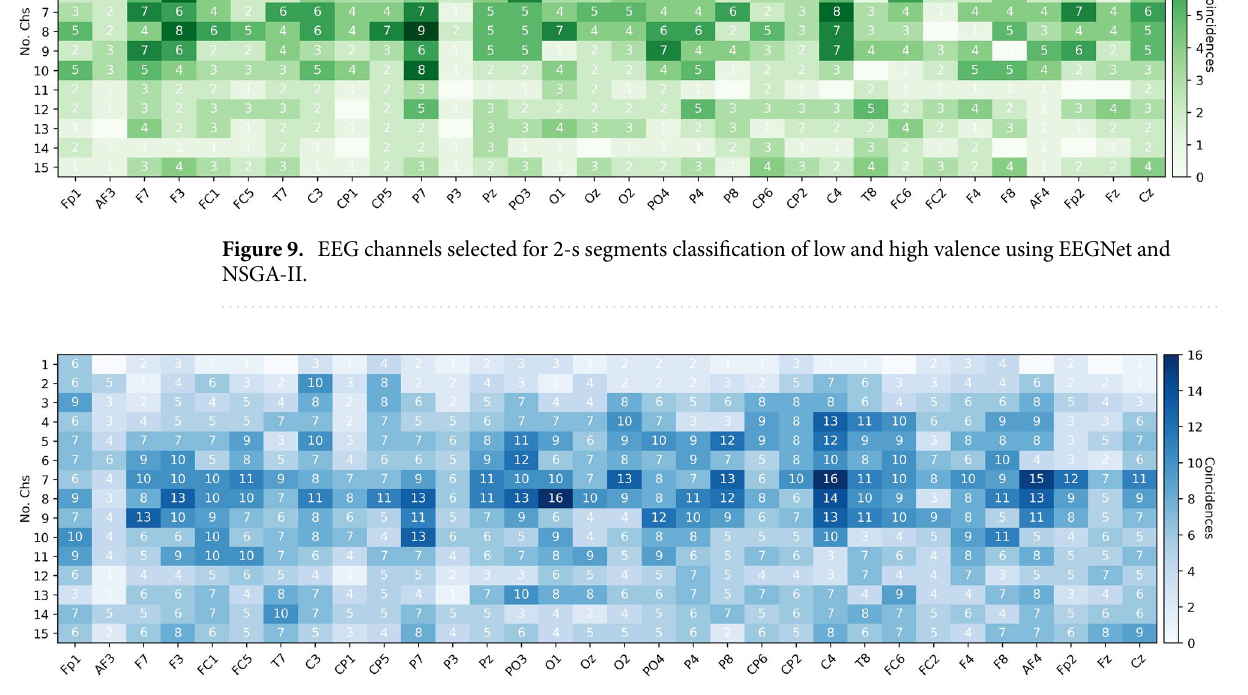
Figure 10. EEG channels selected for classification of both low and high arousal and valence using EEGNet and